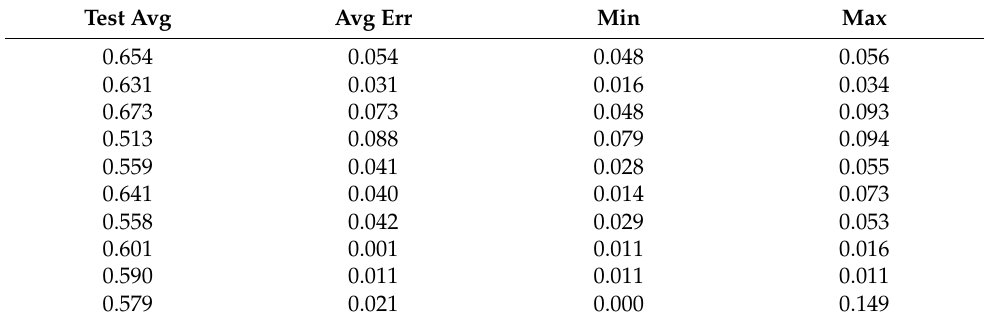
Table A116. Set 2, trials 21–30 data (all 0.5 PR values).